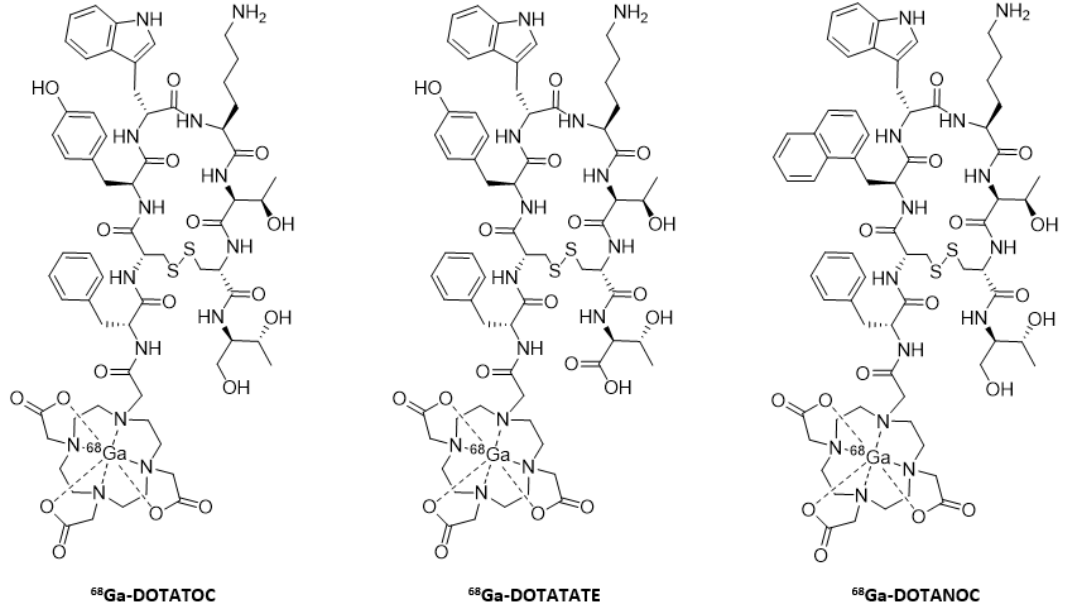
Figure 7. Structures of the three main systems radiolabeled with gallium-68.